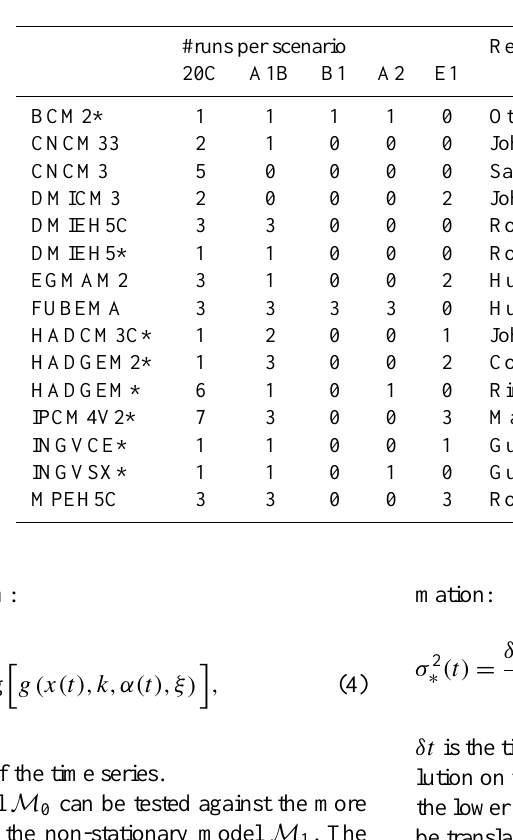
Table 1. Names and number of runs of each experiment with a general circulation model. Models that were not rejected by the statistical test explained in Sect. 2.1 are marked with an